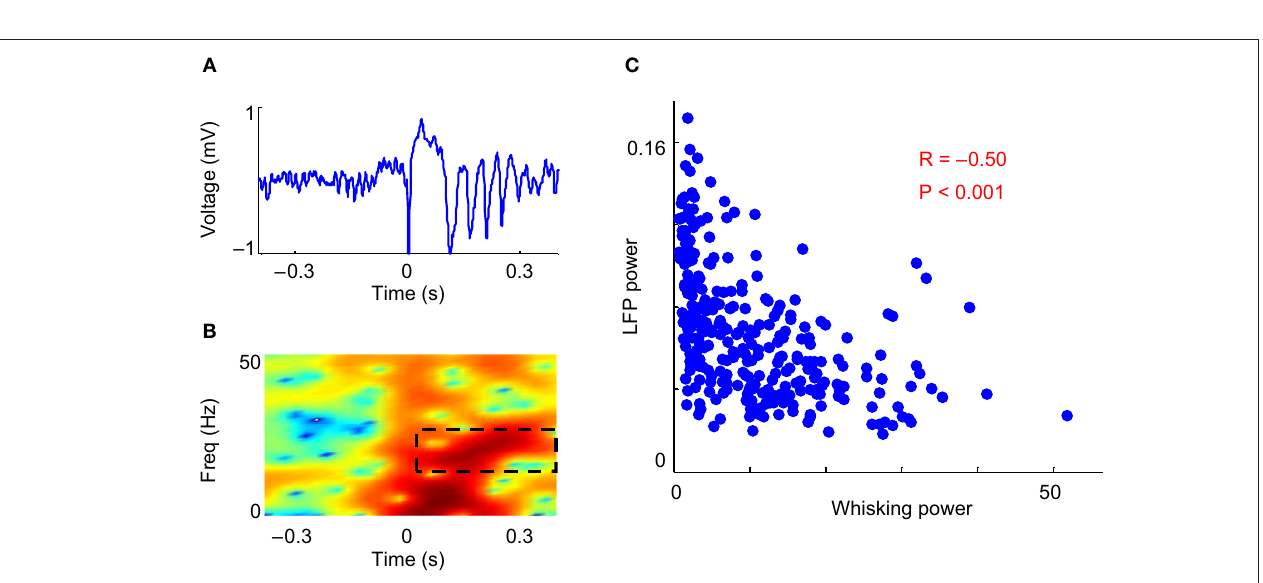
FIGURE 2 | Correlation between whisking and evoked LFP oscillations. (A) Example LFP trace of microstimulation evoked oscillations. (B) Spectrogram of above LFP trace. The power in the 10–20 Hz band from 100–500 ms after microstimulation is used as a metric of the power of the evoked LFP oscillation (dashed black box). (C) Scatter plot shows an inverse relation between the power of the evoked LFP oscillations and the strength of whisking in 300 stimulations on one